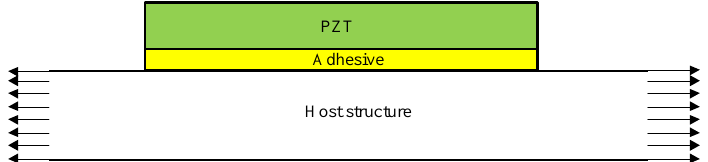
Figure 1. Theoretical model of strain transfer among PZT-adhesive-host structure.